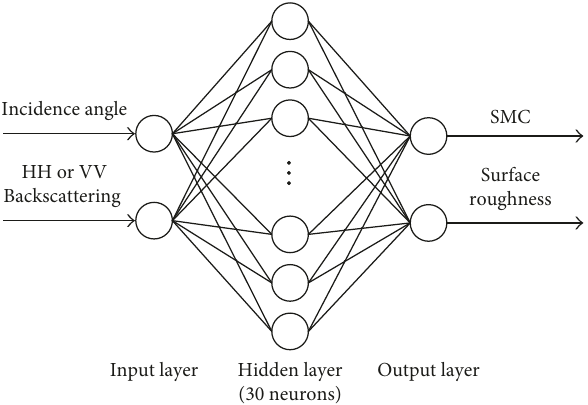
Figure 3: ANN architecture used for SMC